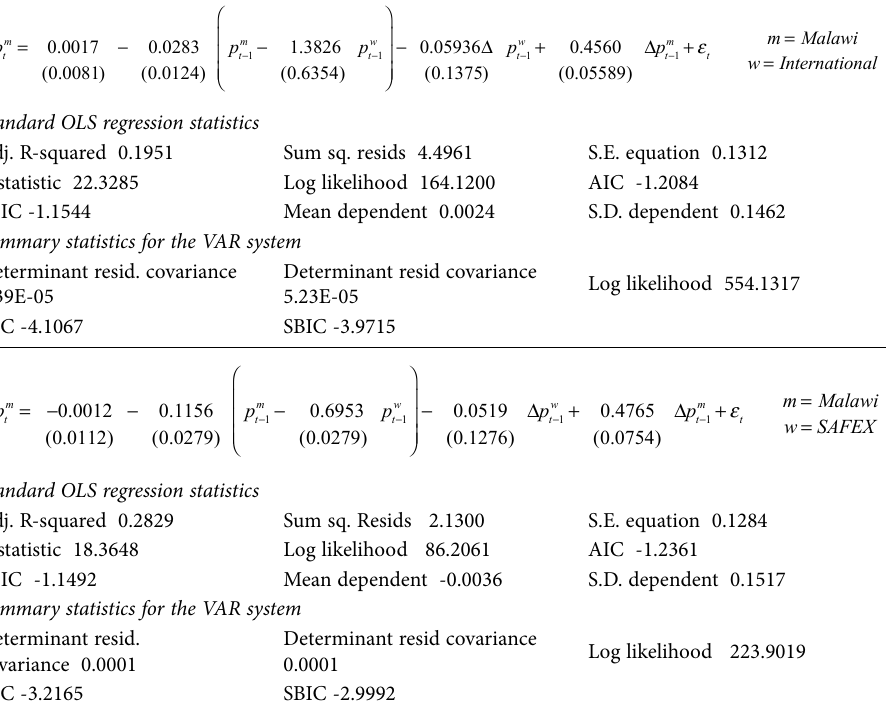
Table 2. Maize price pass-through mechanism (January 1991-March 2013).